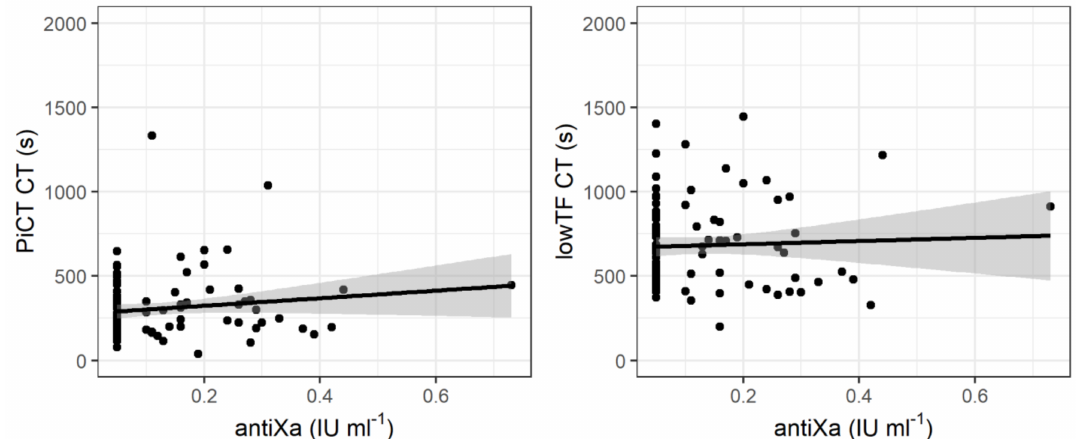
Figure A1. CT, maxV, and maxVt in the regular EXTEM and the two modified (PiCT and low-TF) assays. PiCT: prothrombinase- induced clotting; low-TF: low-tissue-factor; CT: clotting time; maxV: maximum velocity; maxVt: time to maximum velocity; EXTEM: extrinsically activated rotational thrombelastometry